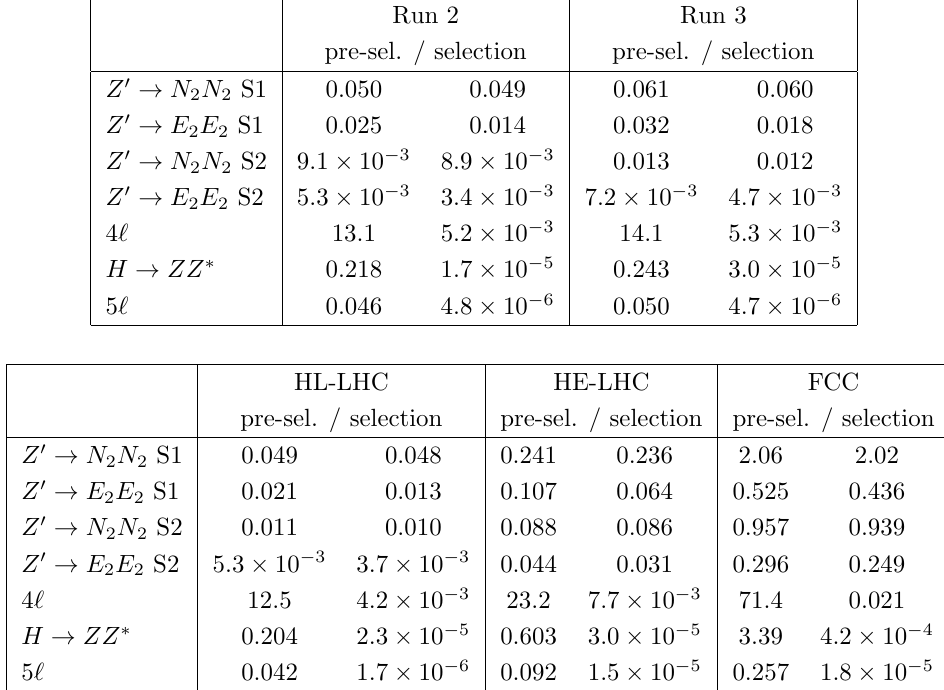
Table 1 . Cross sections (in fb) of the di(cid:11)erent signals and backgrounds at LHC and its upgrades at the pre-selection and (cid:12)nal selection. The signal labels S1, S2 refer to benchmark scenarios 1 and 2, de(cid:12)ned in eqs. (5.1), (5.2). The background labels 4 ‘ and 5 ‘ correspond to four- and (cid:12)ve-lepton production as described in the text.